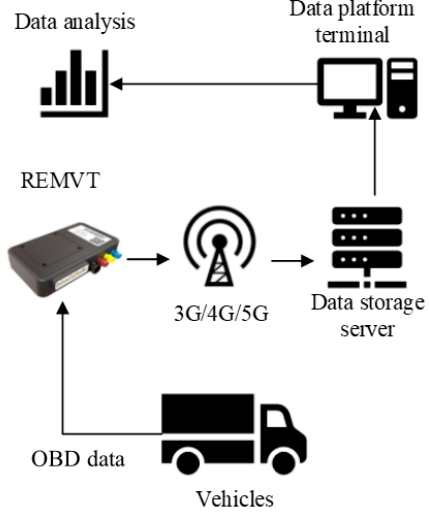
Figure 1. System topology diagram.